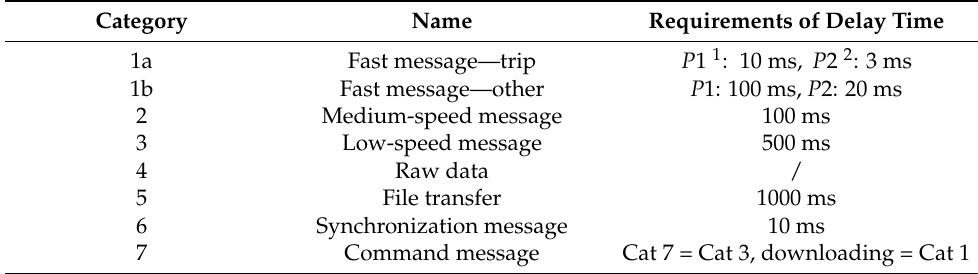
Table 1. Typical response delay of the primary